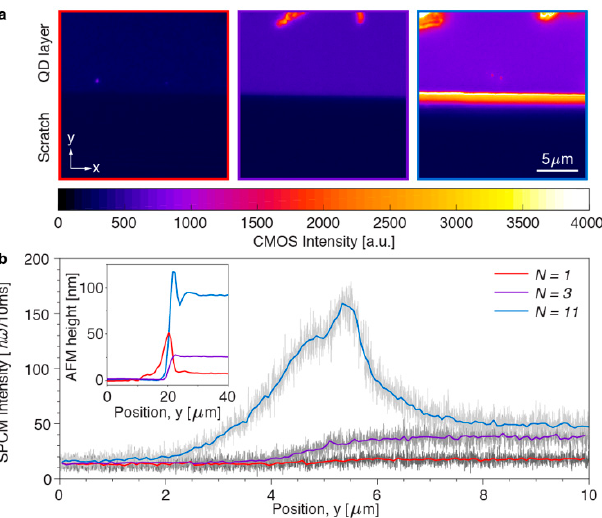
Figure 7. Measurement of the emission from a film of SNPs into air near an edge. ( a ) CMOS images of the fluorescence near the edge of a monolayer (left), a film with three layers (center) and a film with approximately eleven layers (right) of SNPs. ( b ) Single-photon counter measurement of the emission measured with a slit of 50 µm × 1 mm, corresponding to 0.5 µm on the substrate. Inset graph shows the atomic force microscopy (AFM) height profiles for the measured nanostructures.